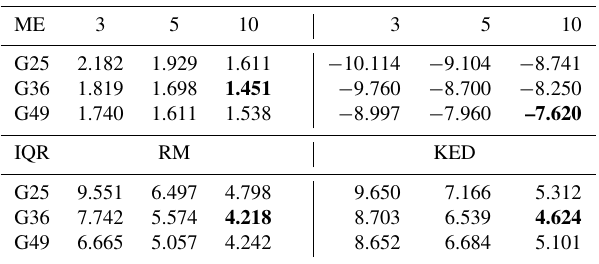
Table 1. The mean error (ME) and the interquartile range (IQR) of the errors w.r.t. the estimated field maxima for the 1000 true rainfall fields obtained by RM (the three columns on the left) and by KED (the three columns on the right). The column name denotes the SNR of the radar estimates whereas the row name denotes the rain gauge